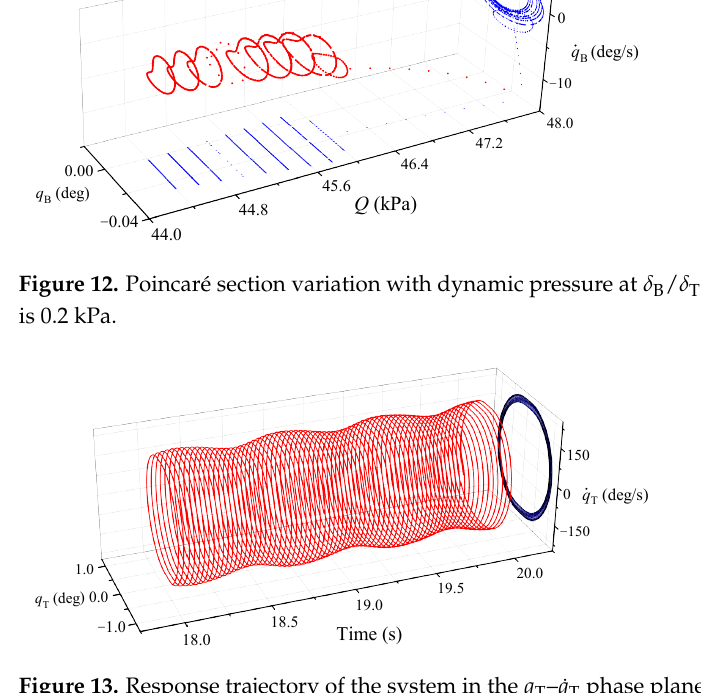
Figure 13. Response trajectory of the system in the q T – ˙ q T phase plane at 45.0 kPa and δ B / δ T =